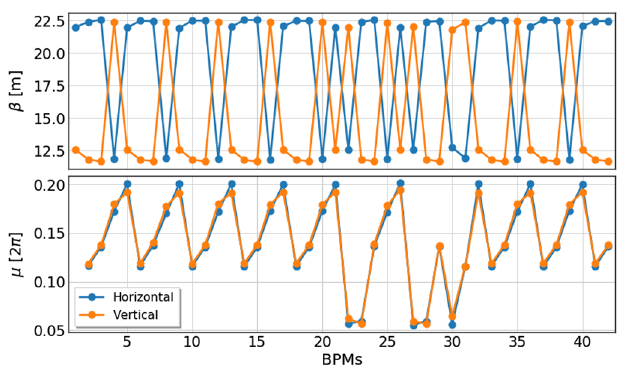
FIG. 9. Beta function (top) and phase advance (bottom) with respect to the index of the 42 BPMs of the PS. The horizontal optics are shown in blue and the vertical in orange.